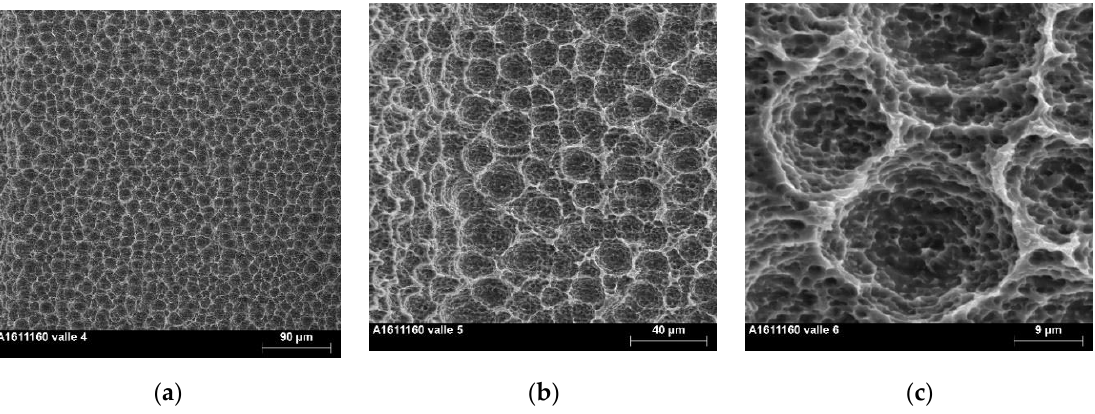
Figure 1. SEM micrographs of the implant surface. ( a ) Micrograph taken at 100× magnification. Note the homogeneous honeycomb macro-structure; ( b ) Micrograph taken at 500× magnification. Note the honeycomb-like macro-structure and the micro-pores for bone ingrowth, similar to a typical SLA surface topography; ( c ) Micrograph taken at 2000× magnification. Note the pores of the micro-texture superimposed on the rounded regular macro-structure.